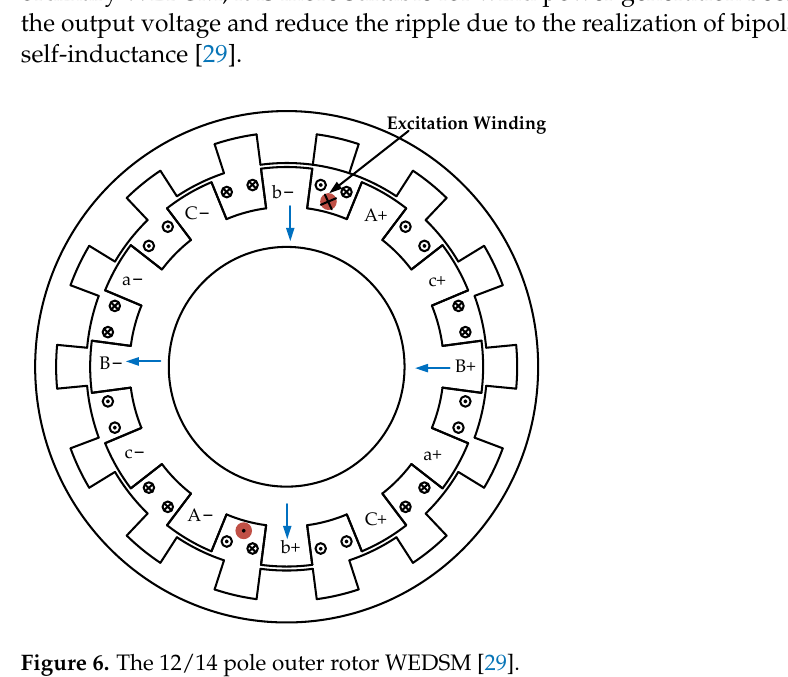
Figure 8. Output torque of three groups of machines under different excitation currents [31]. SRM is widely used in the field of electric vehicles because of its simple manufacture and durability, but its vibration caused by the torque ripple has been criticized. As shown in Figure 9, a double-layer SRM is proposed in [34] to reduce the torque ripple and realize smooth operation of the machine by optimizing the topology of SRM. Not limited to the double-layer structure, a higher-level SRM machine topology is proposed in [35,36]. By adopting an optimized multi-level structure, the torque ripple, vibration, and noise of the SRM are effectively reduced. Figure 9. The structure of a double-layer SRM [34].